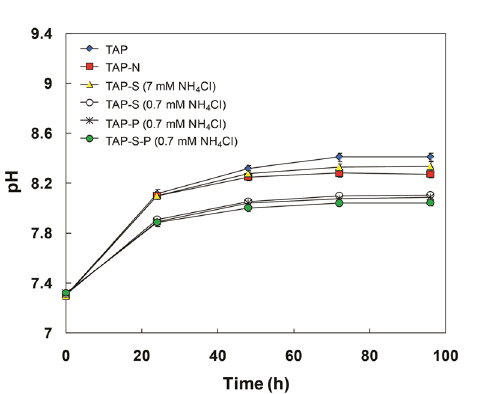
Fig. 4. Change in pH of C. sorokiniana during the incubation of synchronized cells in TAP, TAP-N, TAP-S (7 mM NH Cl), TAP-S (0.7 mM NH Cl), TAP-P (0.7 mM 4 4 NH Cl), TAP-S-P (0.7 mM NH Cl) 4 4